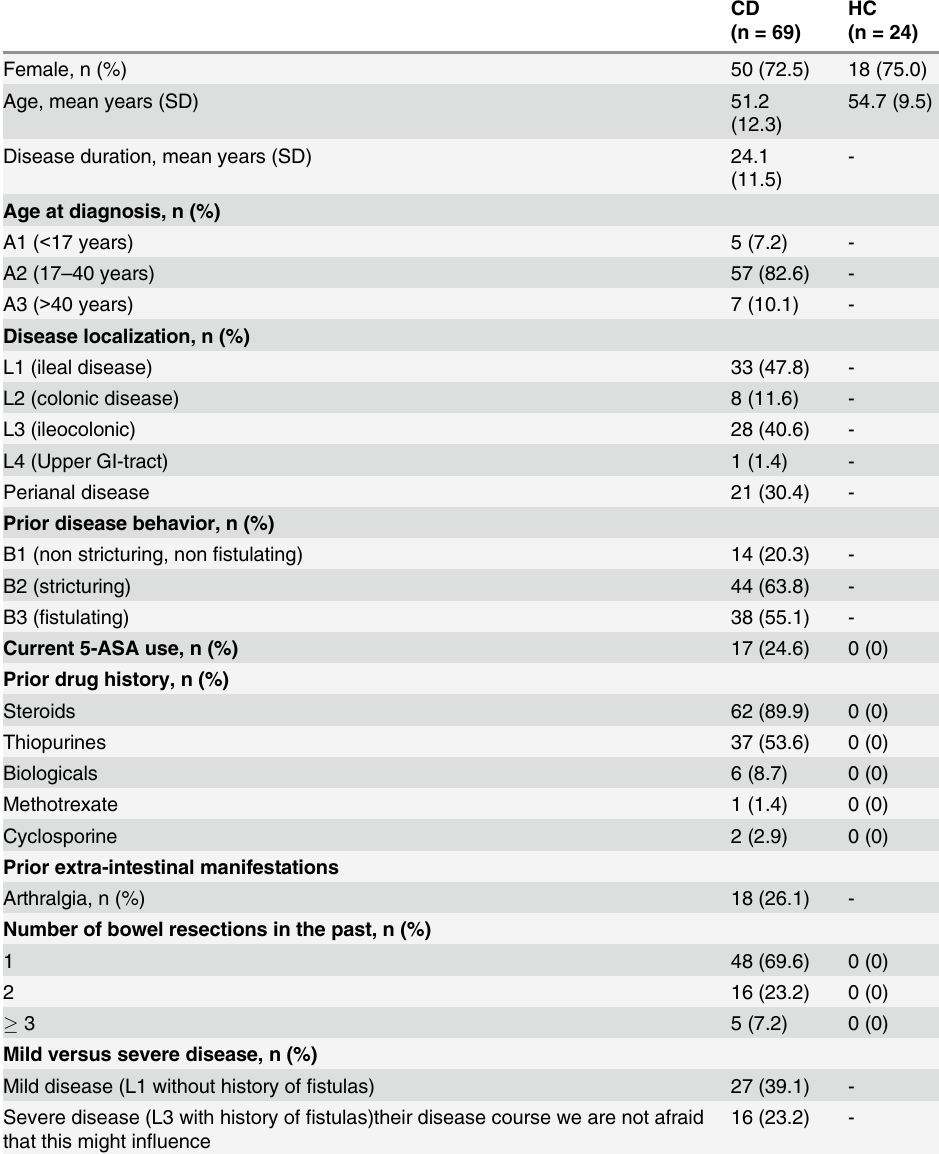
Table 2. Baseline characteristics of the included patients with CD and